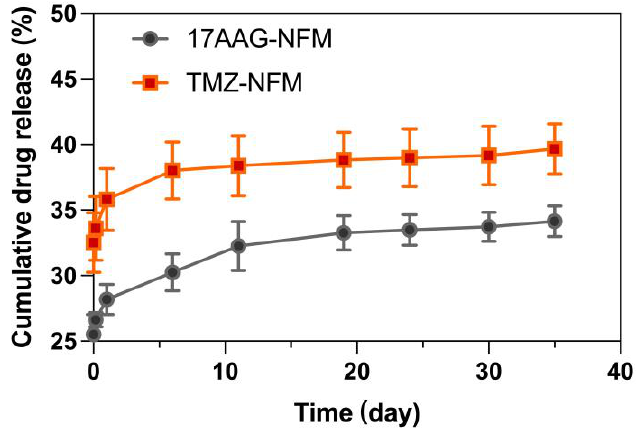
Figure 5. Cumulative release of 17AAG and TMZ from NFM in PBS solution for 35 days.